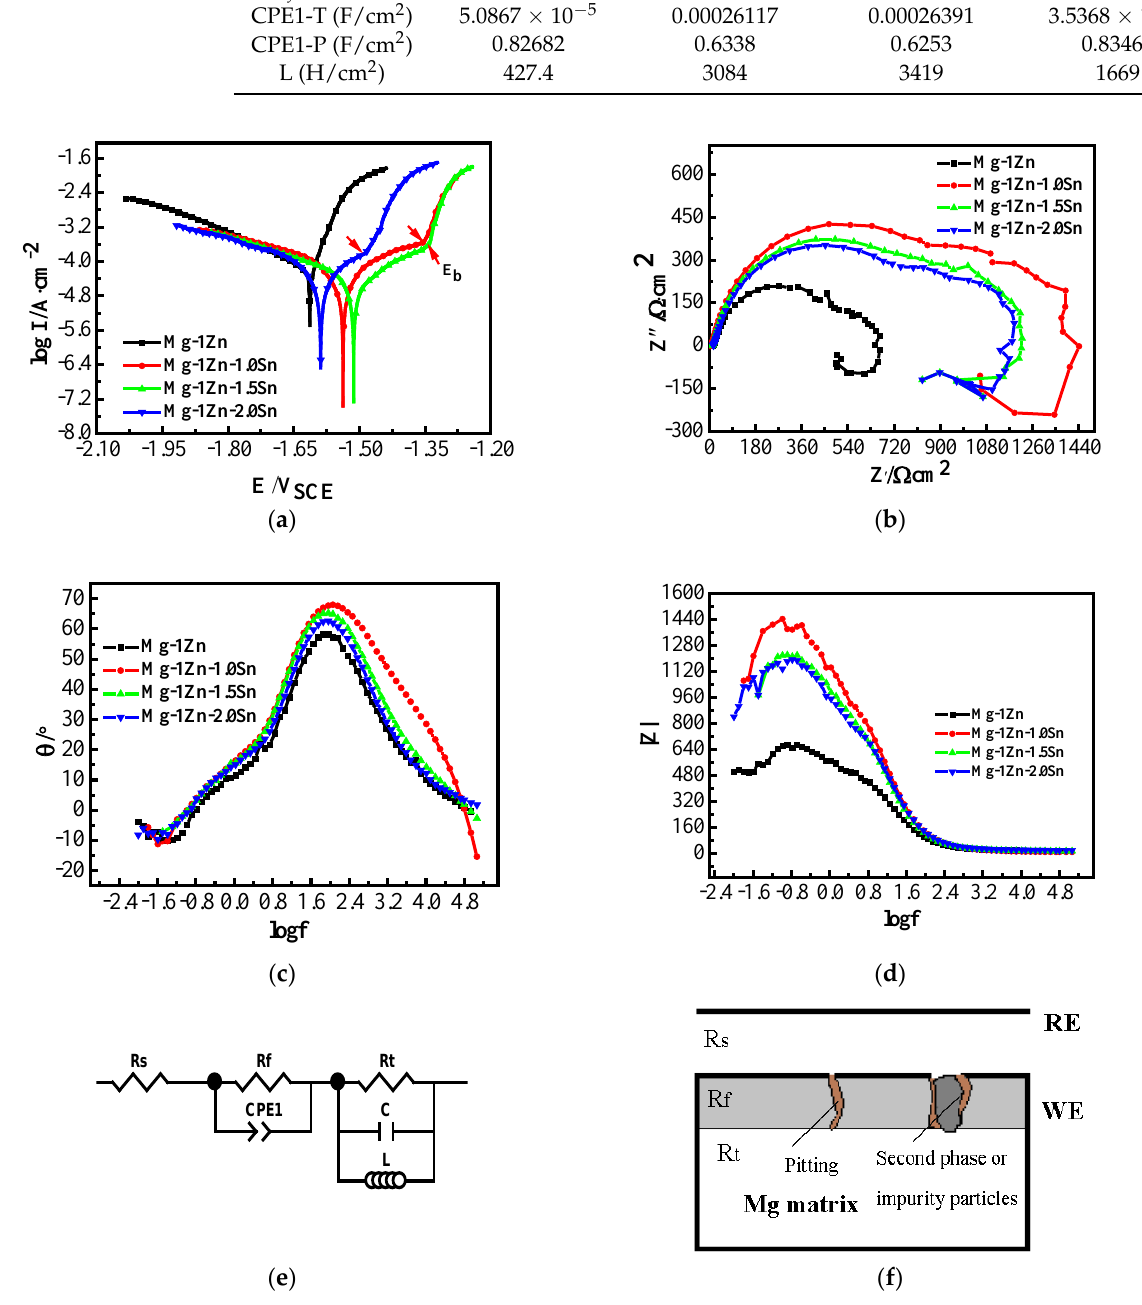
Figure 4. Electrochemical tests results: potentiodynamic polarization curves ( a ); EIS spectrum- Nyquist plot ( b ), |z|-logf plot ( c ), and θ -logf plot ( d ) of the alloys; equivalent circuit model ( e ) and physical model ( f ). RE = reference electrode, WE = working electrode. Table 4. Parameters of the alloys fitted from potentiodynamic polarization curves.